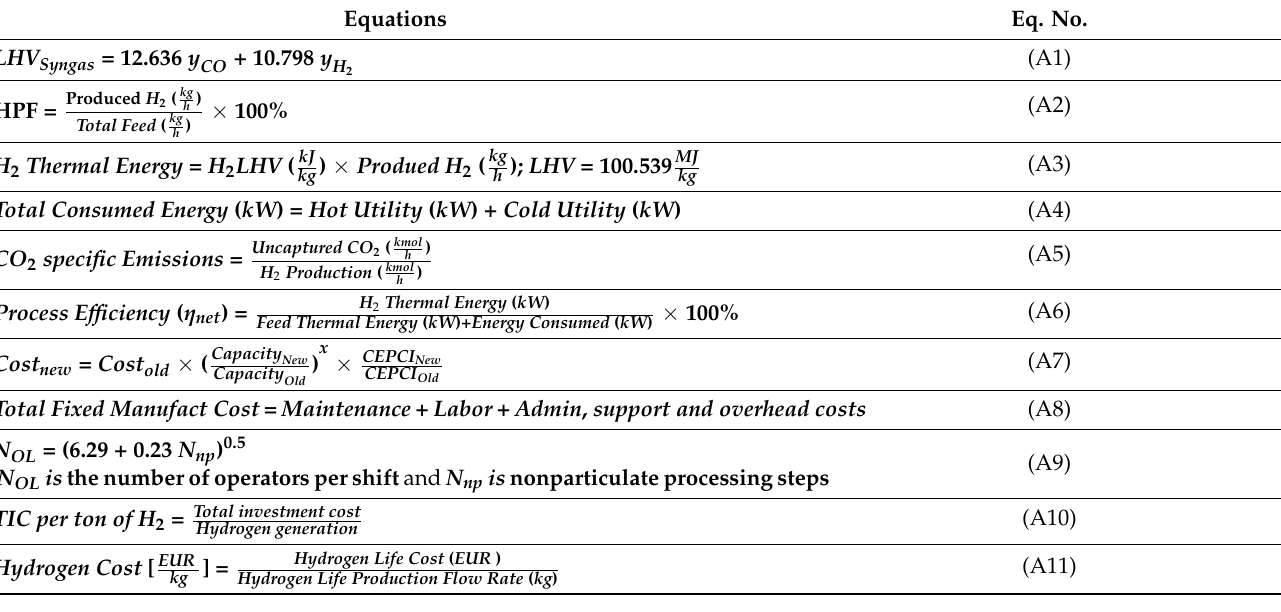
Table A2. Equations used for technical and economic appraisal.